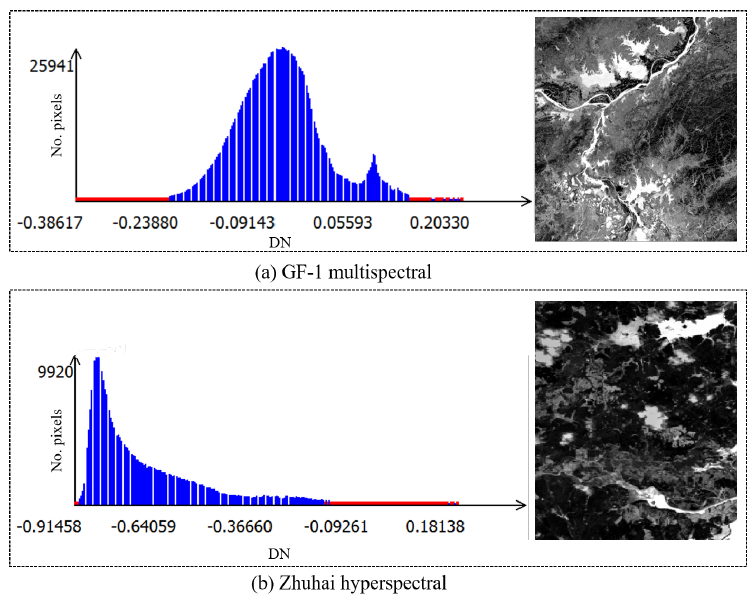
Figure 7. The statistics of WI values of GF-1 and Zhuhai-1 hyperspectral datasets.